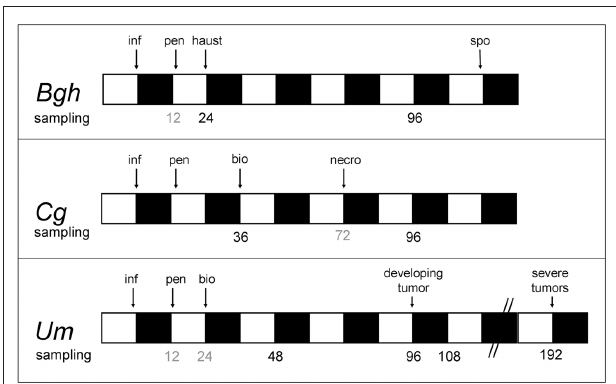
Figure 1 | Mapping of sampling time points to respective infection stages in the three studied interactions. Bgh – barley ( cv. Golden Promise ) infected with Blumeria graminis f.sp. hordei isolate A6 (Wiberg, 1974); Cg – maize ( cv. Early Golden Bantam ) infected with Colletotrichum graminicola strain CgM2; Um – maize ( cv. Early Golden Bantam ) infected with the solopathogenic Ustilago maydis strain SG200 (Kämper et al., 2006). White bars indicate light period, and dark bars indicate dark period. Sampling time points analyzed in this study are indicated in black below the bars, while sampling time points that were disregarded are printed in gray. inf, Inoculation; pen, penetration, bio, initiation of biotrophic growth, haus, haustoria establishment; necro, commencement of necrotrophic growth; spo, formation of